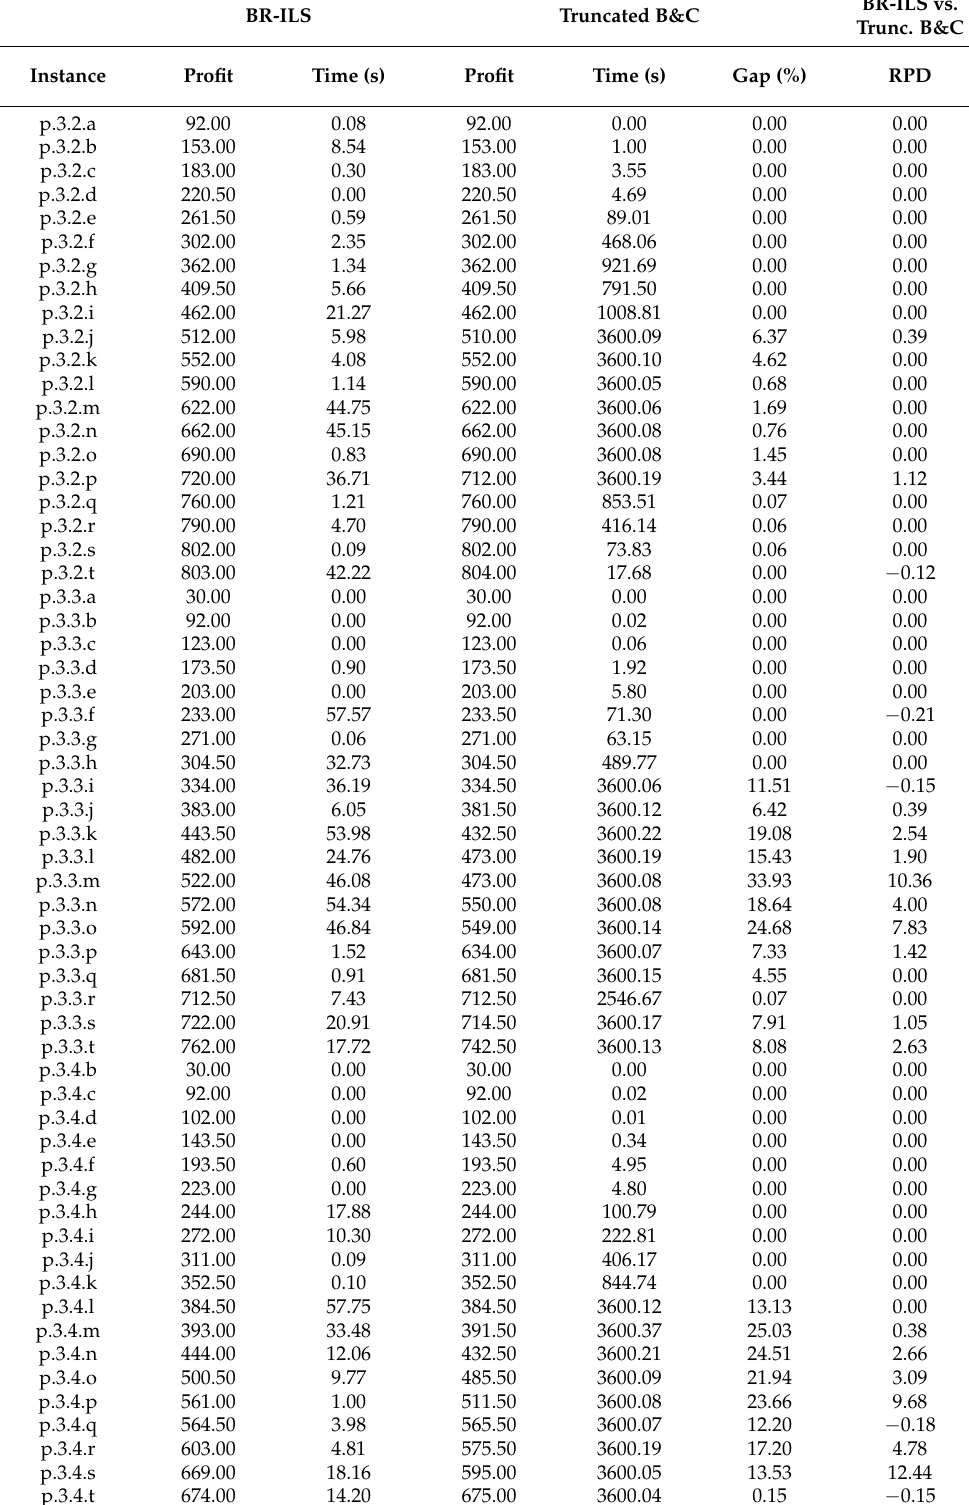
Table 4. Results given by the BR-ILS and the truncated B&C ( F 2) models for p 3